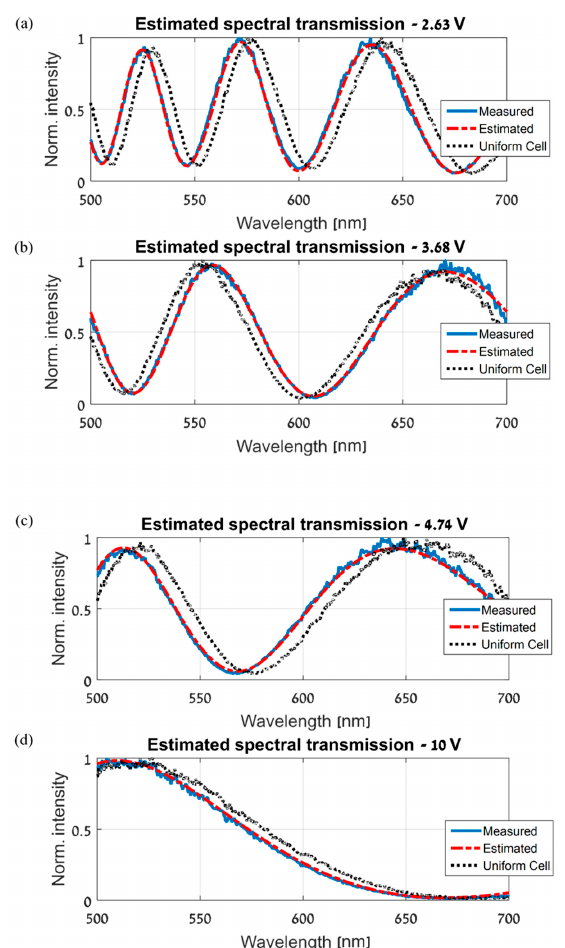
Figure 12. ST spatial estimation results at different voltages and locations on the CS-MUSI’s LCC. In each of Figures 12 a – d , the continuous blue line is the measured ST at a specific location and voltage. The dashed red line is the estimated ST at the same location and voltage. Lastly, The dotted black line is the ST measured at the same voltage, but at the base location, demonstrating the error obtained without applying the proposed spatial estimation algorithm (that is, if a spatially uniform LCC is assumed, with a cell gap equal to the gap at the base location).